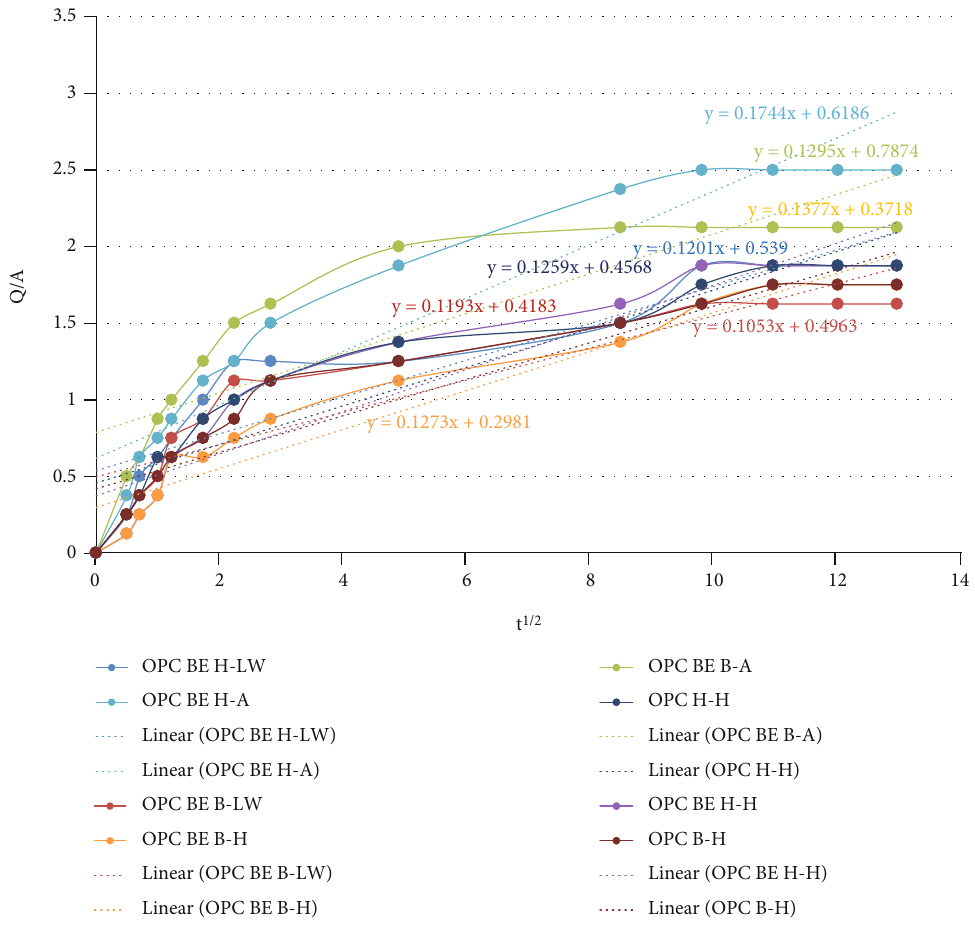
Figure 5: Sorptivity coe ffi cients for OPC test mortar prisms cured for 28